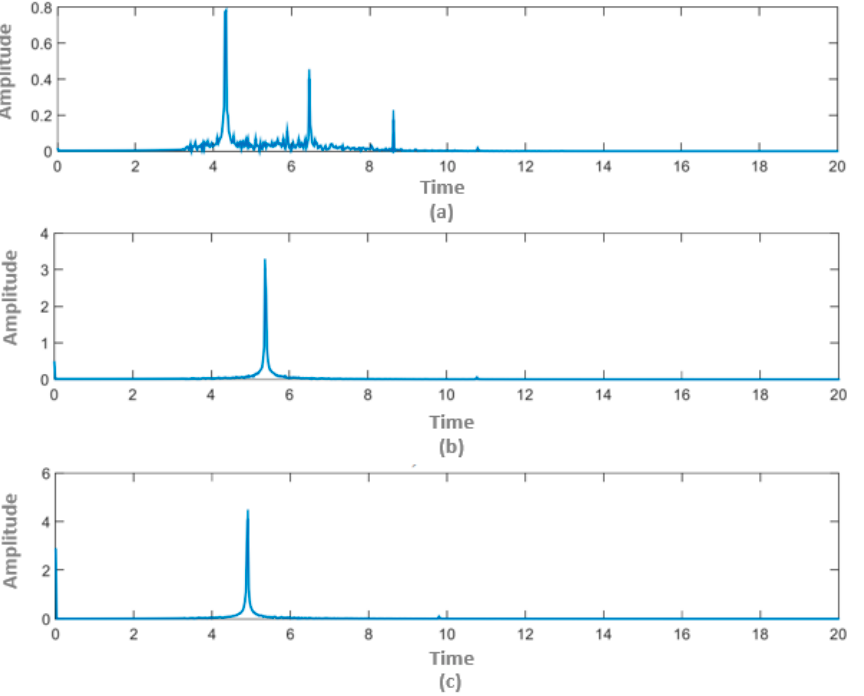
Figure 11. Experimental results of the non-gyro case with respect to three levels: ( a ) easy, ( b ) medium, and ( c ) hard.